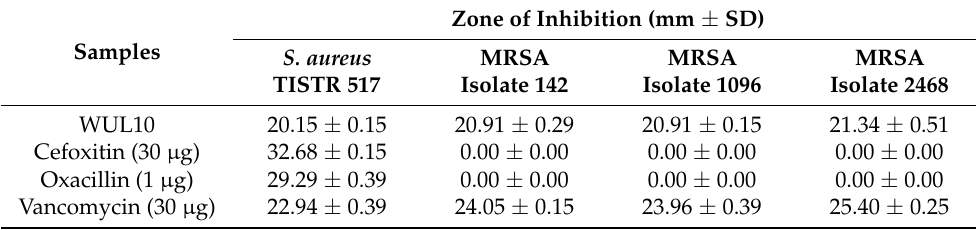
Figure 3. Growth curve and production kinetics of antimicrobial substances from WUL10. Table 1. Agar well diffusion of WUL10 supernatant after 24 h culture and antibiotics (means ± SD; n =